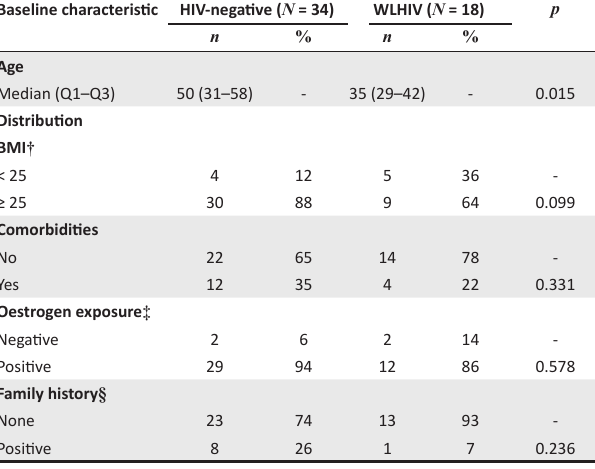
TABLE 1: Demographics and clinical parameters of study sample. Baseline characteristic HIV-negative ( N = 34)